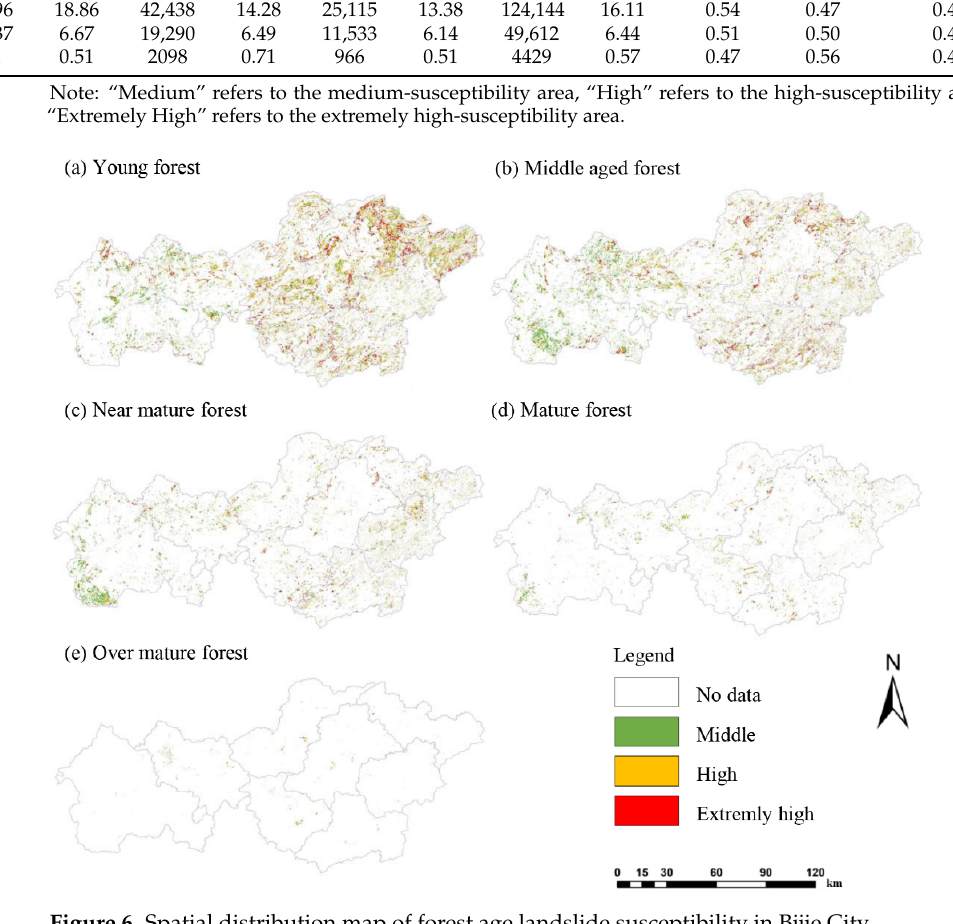
Table 3. Relationship between forest age groups and landslide susceptibility in Bijie City.